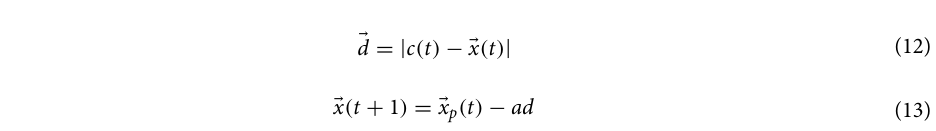
x is the grey wolf position, t is the iteration, (cid:31)